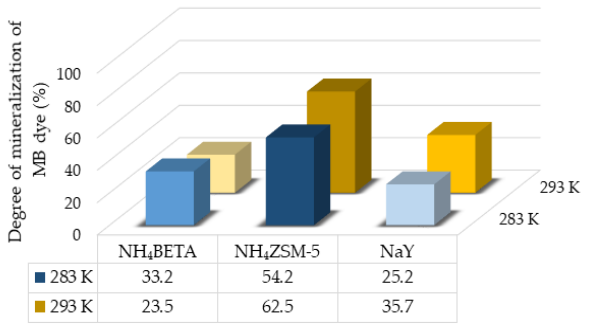
Figure 12. Mineralization degree of MB dye in the presence of selected zeolites after 180 min under UV radiation at two temperatures.